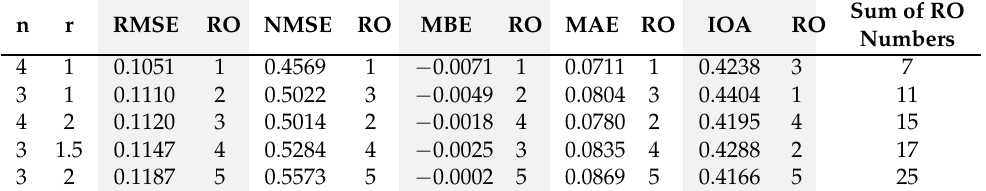
Table 5. The calculated statistical metrics for the evaluated IDW interpolators for N-NO 3 , the ranking order of each interpolator and the sum of the ranking order numbers.